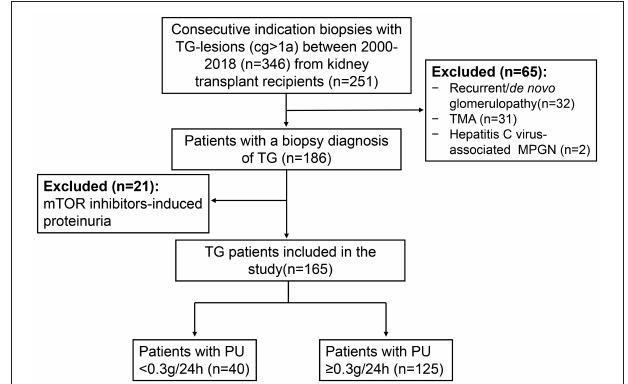
FIGURE 1 | Flow chart of TG patients enrolled in the study. There were a total of 2,375 indication biopsies were performed due to elevated creatinine and/or proteinuria from 2000 to 2018 in our center. TG-lesions were found in 346 biopsies from 251 kidney transplant recipients. Biopsy cases with recurrent/ de novo glomerulonephritis ( n = 32), TMA ( n = 31), hepatitis C-virus associated MPGN ( n = 2) were excluded. After further excluding the patients with mTOR inhibitors-induced proteinuria (PU ≥ 0.3g/day, n = 21), a total of 165 patients were enrolled in our study. TG, transplant glomerulopathy; cg, chronic allograft glomerulopathy; TMA, thrombotic microangiopathy; MPGN, membranoproliferative glomerulonephritis; mTOR, mammalian target of rapamycin; PU,